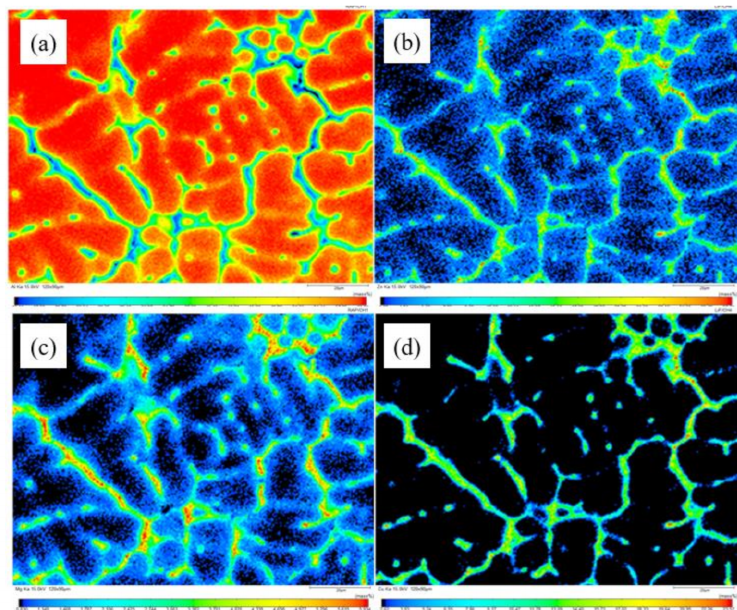
Figure 10. Main elemental distribution in SC sample of Alloy C: ( a ) Al; ( b ) Zn; ( c ) Mg; (d) Cu.